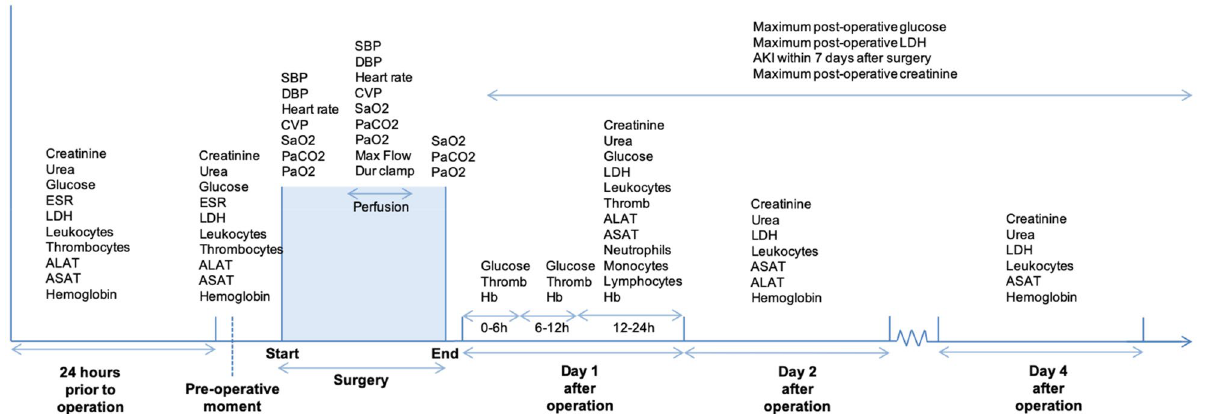
Figure 5. Timeline of clinical measurements before, during, and after cardiac operation, in the intensive care unit (day 1 after operation), day 1 in the ward (day 2 after operation), and day 3 in the ward (day 4 after operation). Patient characteristics are not included here, but described in detail in Table 1. Dur CA duration of cardiac arrest, Dur clamp duration of aortic cross-clamp, Hb hemoglobin, ASAT aspartate aminotransferase, ALAT alanine aminotransferase, Thromb thrombocytes, ESR erythrocyte sedimentation rate, LDH lactate dehydrogenase, CVP central venous pressure, PaCO 2 arterial carbon dioxide partial pressure, SaO 2 oxygen saturation, PaO 2 arterial oxygen partial pressure, SBP systolic blood pressure, DBP diastolic blood used for training each candidate algorithm 14 . This means that each patient is used only once in the validation set, and included in the training set for all other rounds. For each candidate learner, k risks are calculated and averaged into a “cross-validated risk”. Subsequently, the learners with the minimal risk are selected, applied to the entire dataset and included in the new weighted estimator (the SL), that attributes a relative coefficient to each of the learners. Those which reduce the calculated risk the most, will contribute to the final weighted pre- diction. Moreover, the SL presents individual patient predicted probabilities for 5-year mortality per ensemble. Five candidate algorithms were included in the SL: support Bayesian additive regression trees (BART), extremely rithm varies greatly depending on its hyper-parameters and can be substantially improved by tuning, multiple hyper-parameter combinations were generated for each candidate algorithm. Details of each of these algorithms including the hyper-parameters, the tuning process, and final values are described in the “Supplementary ma- terial”. A 10-fold cross-validated generalized linear regression model (GLM) was trained on data from the full cohort for use as baseline comparison of the SL’s performance. Lastly, to test the performance of a model using only pre-operative data in predicting post-operative outcomes, a 10-fold cross-validated XGBoost model was trained on data from the full cohort.